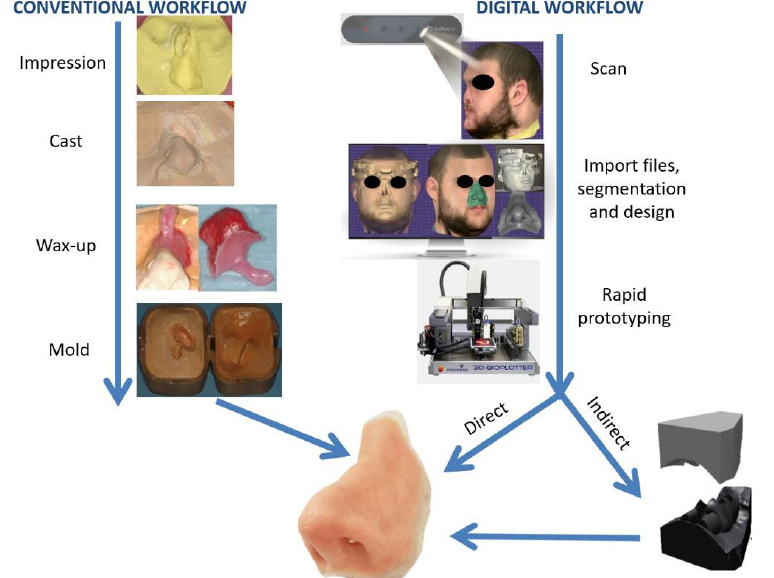
Figure 2. Comparison of conventional and digital workflows for nasal extraoral prosthesis manufacturing. For the conventional technique ( left ), an impression is taken of the defect and surrounding tissue, followed by a casting and wax-up of the prosthesis with a holding support for facilitating the try-in, creating the mold. For the digital technique ( right ), 3D scanning is performed with a Bellus Arc 1 facial scanner, followed by importing the files into a computer-aided design (CAD) program, designing the prosthesis and printing the mold (indirect path) or the final nasal prosthesis directly using a 3D printer.